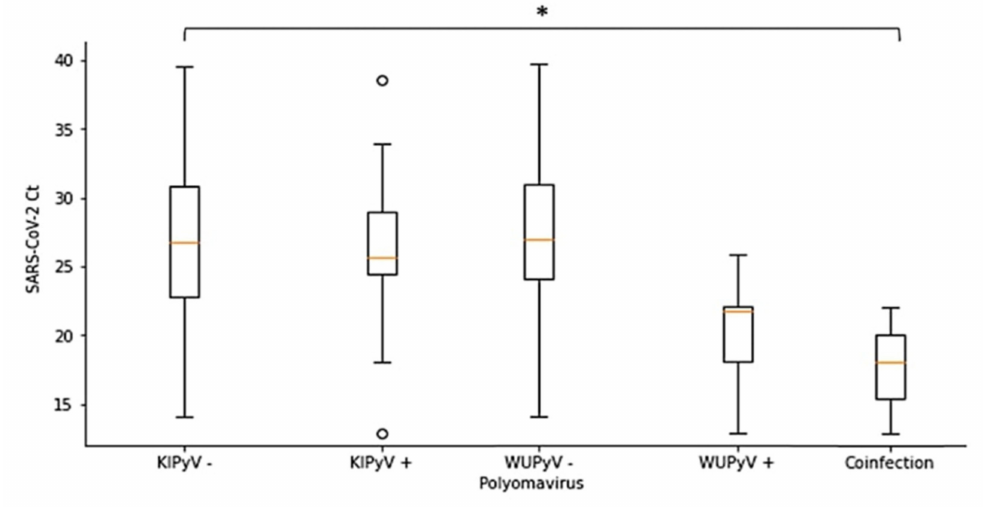
Figure 1. Distribution of Ct of SARS-CoV-2 according to the presence or absence of KIPyV and WUPyV. *: p < 0.05 (Kruskal-Wallis test), o: